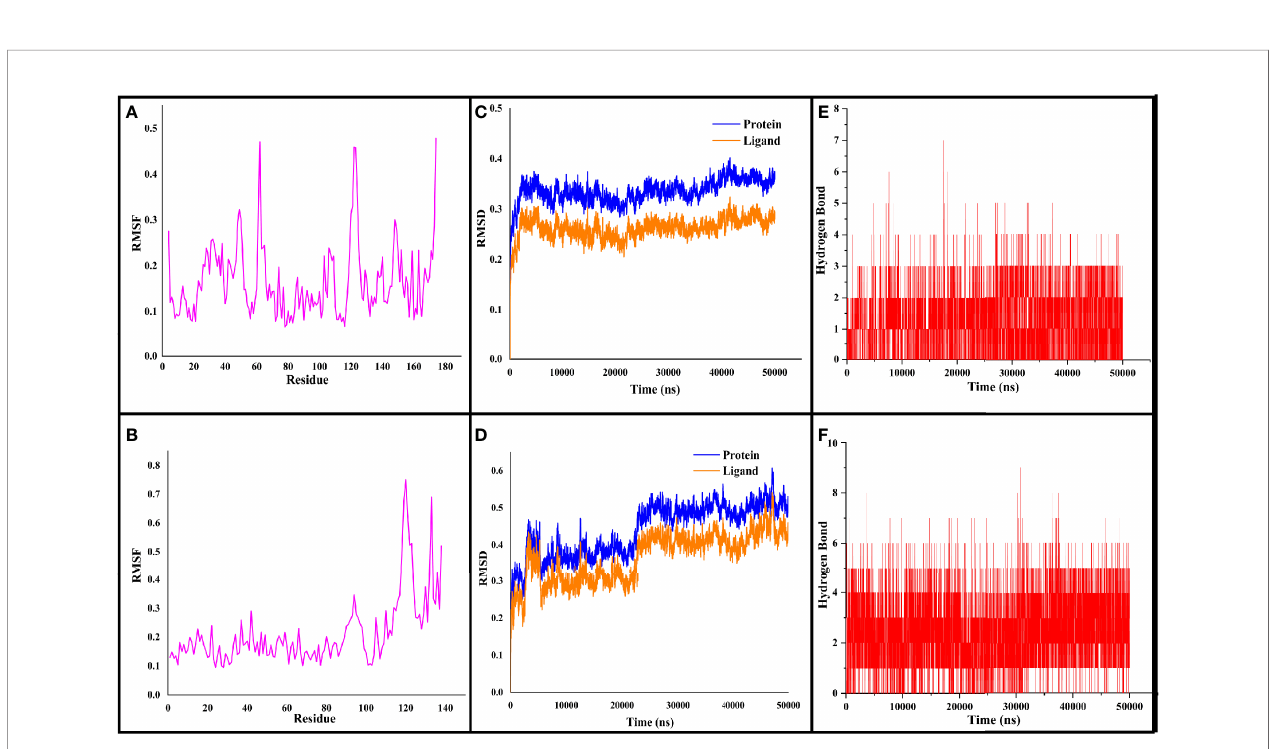
FIGURE 4 | The RMSF, RMSD, and hydrogen bond values plotted for CYCc-QSSM 1157 (A – C) and RAS1-QSSM 1112 complexes (D – F) during 50-ns MD simulation. RMSF, root mean square fl uctuation; RMSD, root mean square deviation; MD, molecular